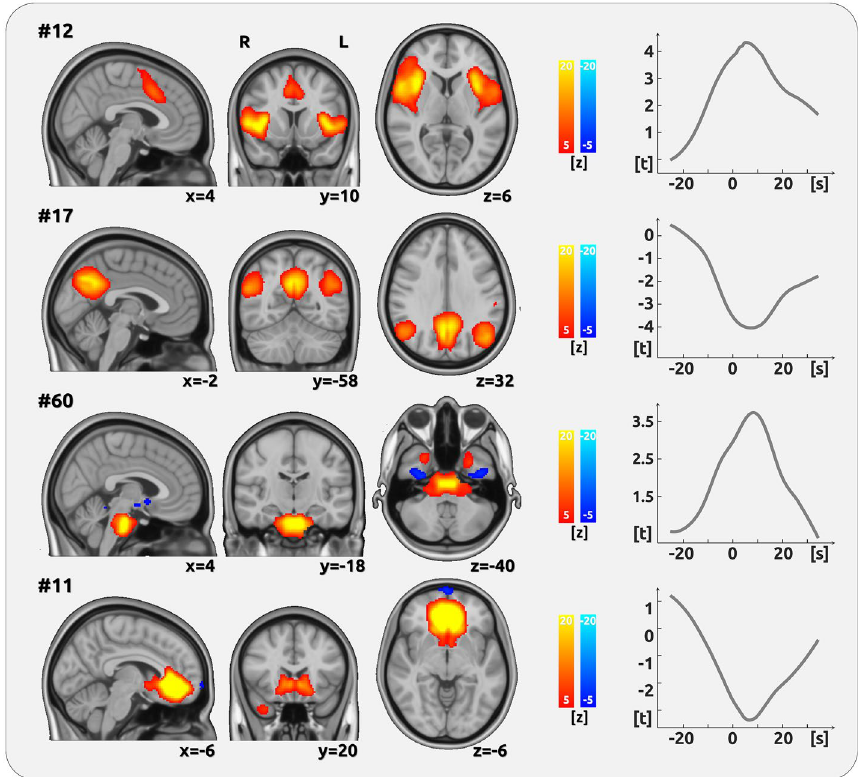
Figure 1. Encoding of pain amplitude for CBP. The figure shows the four networks whose time course exhibited a significant positive relationship with the time course of pain intensity (AMP). The cortical maps on the left side show the spatial characteristics of the networks and are the result of the Melodic ICA. Z-scores were also determined by Melodic and depict the contribution of each voxel to the respective network. The right side exhibits the analysis of the component time courses. The time courses, which are the output from the dual regression, were related to the time course of pain ratings using LMEs. The graph shows the results of the shifts between − 25 and 35 s in relation to the current rating (0 s). One significant network component (#12) essentially comprises the insular cortex and the posterior part of the anterior cingulate cortex. A further component with a positive relationship with pain is mainly related to pontine activity (#60). Negative relationships were found for the posterior (#17) and the anterior part of the DMN (#11).